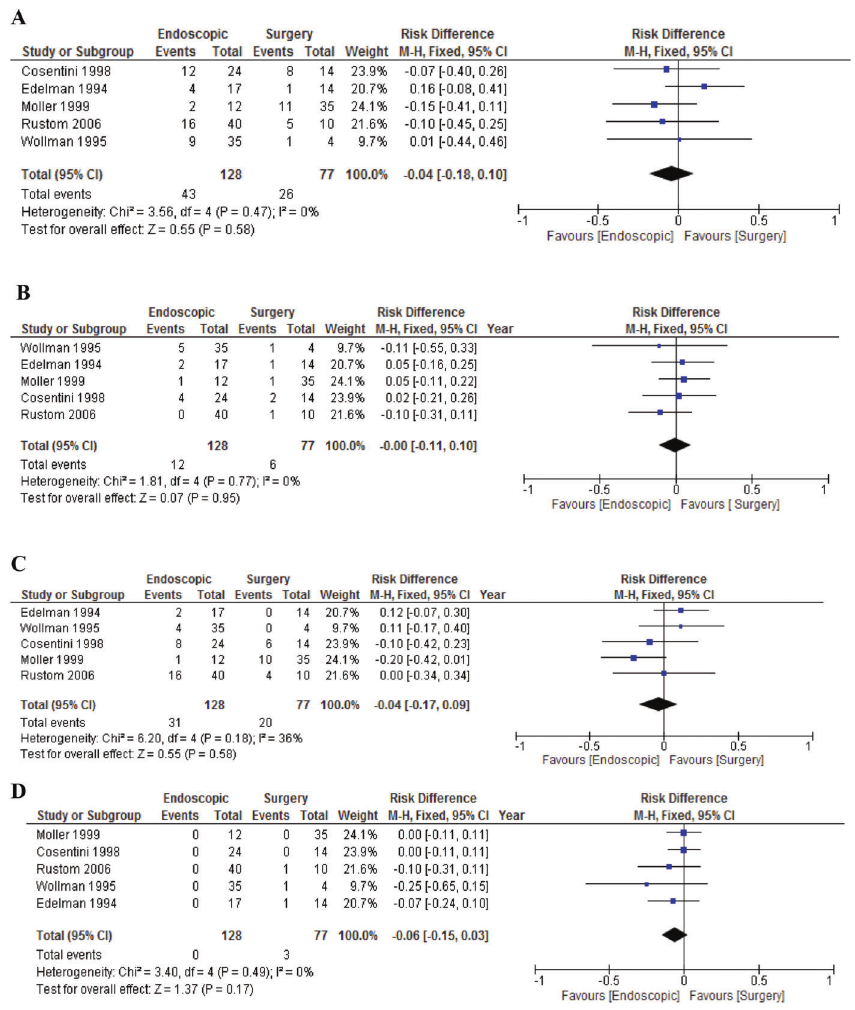
Figure 2 - Summary of meta-analysis of retrospective studies. (A) meta-analysis--all complications in retrospective studies. (B) meta- analysis of major complications in retrospective studies. (C) meta-analysis of minor complications in retrospective studies. (D) meta- analysis of mortality related to procedures in retrospective